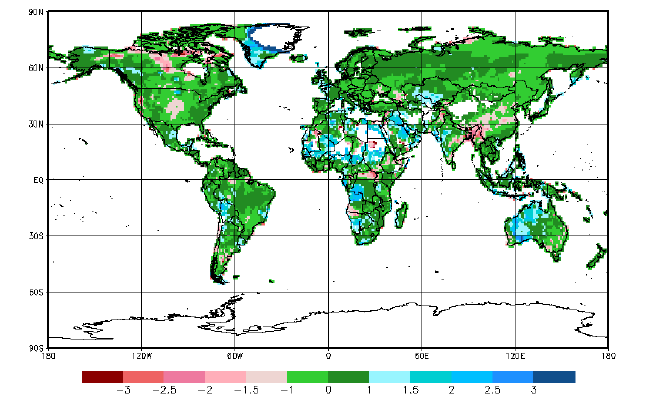
Figure 11. The GPCC-DI with 3-month accumulation interval for January 2014. The color scale is the same as in Fig. 3.